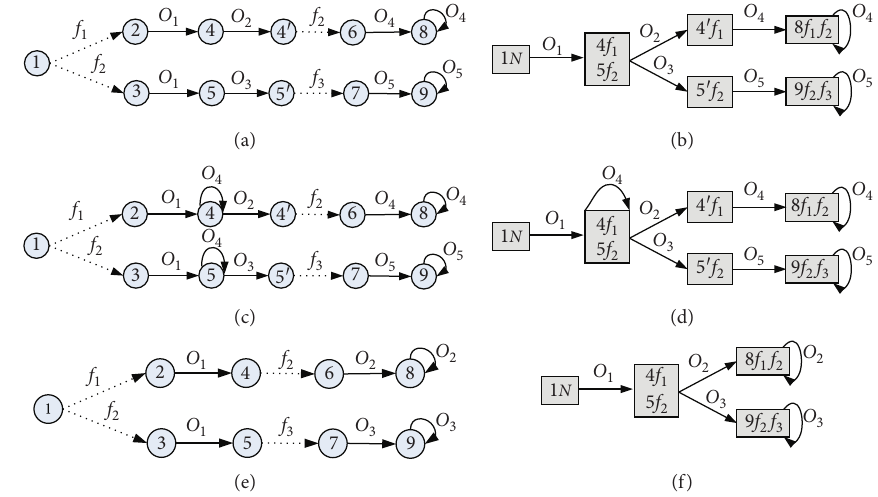
Figure 3: DES models and minimal diagnosers. (a) DES model G diagnoser G 2 m for G 2 . (e) DES model G 3 . (f) Minimal diagnoser G 3 m for G 3